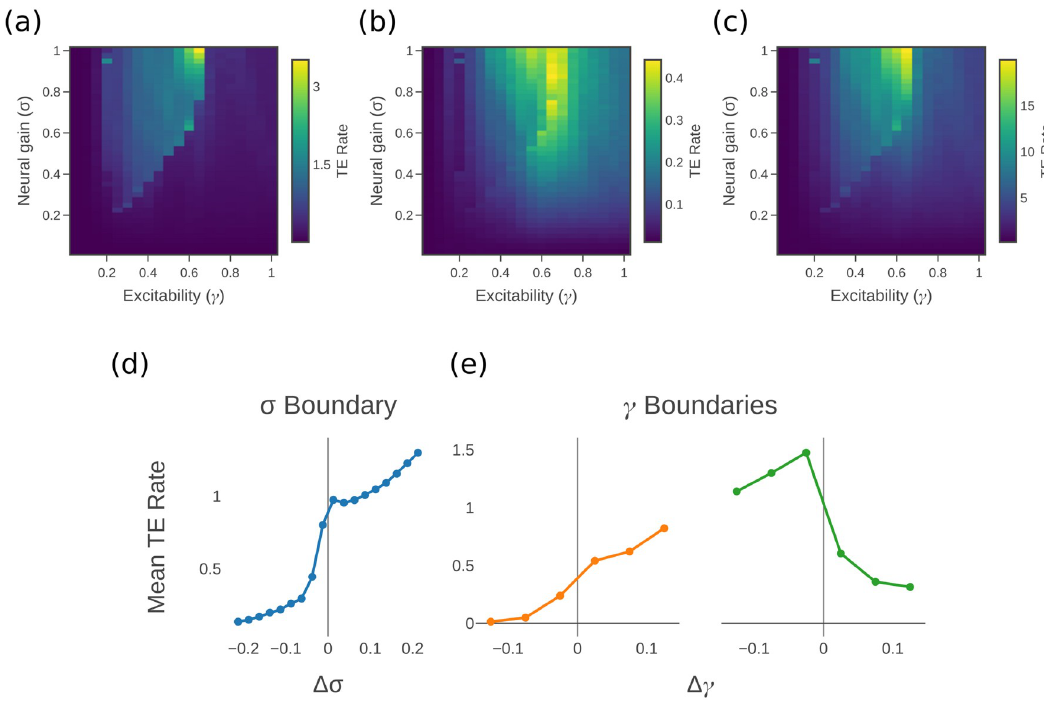
Fig 3. Measures of information transfer. (a) Average transfer entropy rate over causal edges (those connected source ! target by the directed connectome). (b) Conditional transfer entropy rate over causal edges. (c) Collective transfer entropy rate of causal edges. (d) and (e) Mean TE rate across σ boundary and γ